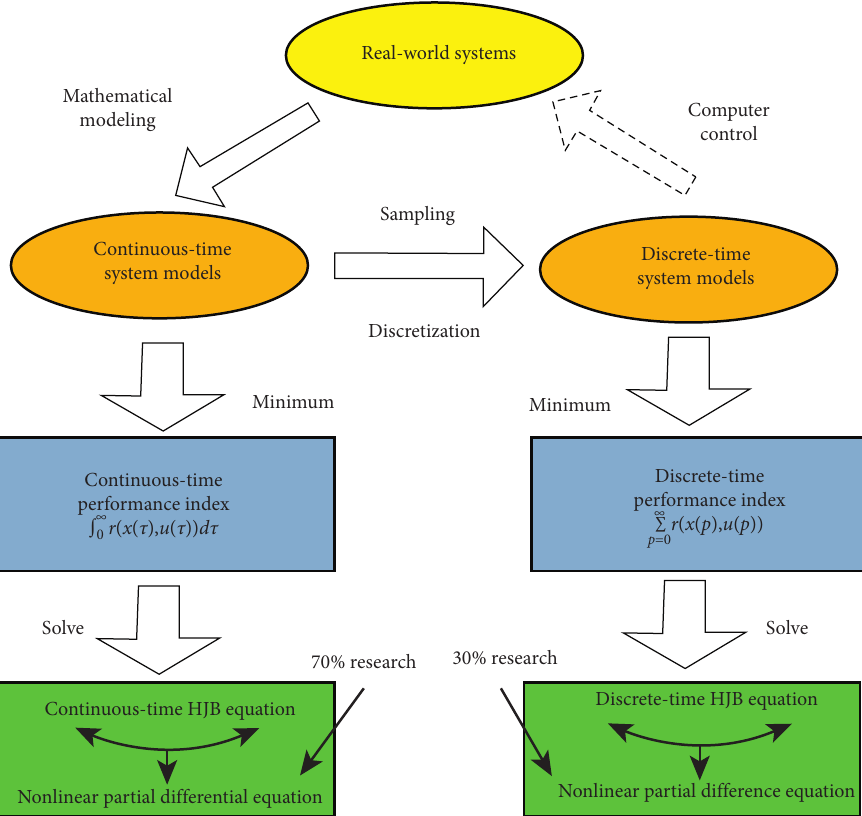
Figure 1: Relationship and difference between discrete-time and continuous-time optimal